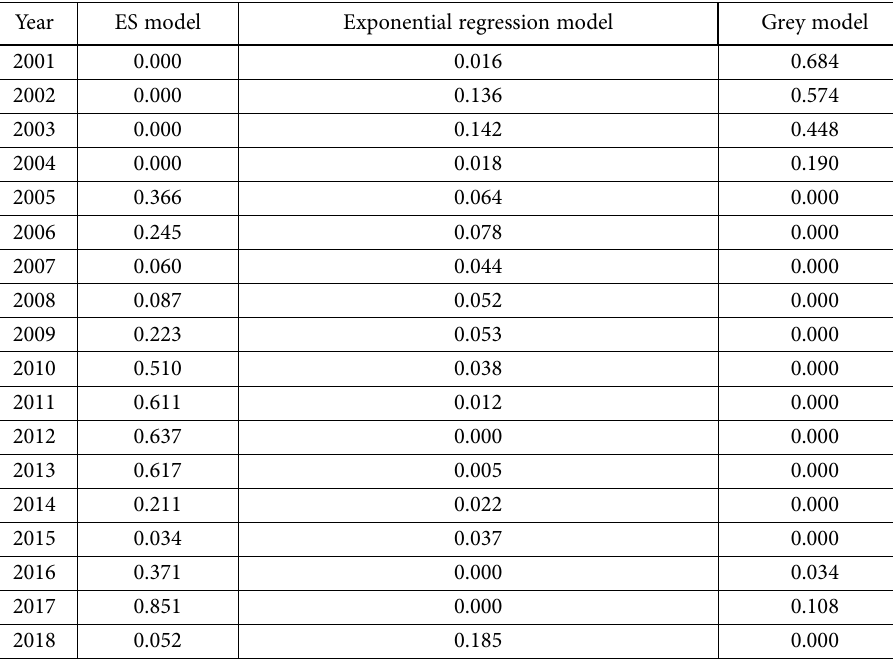
Table 7. Similarities and weights ES model Exponential regression